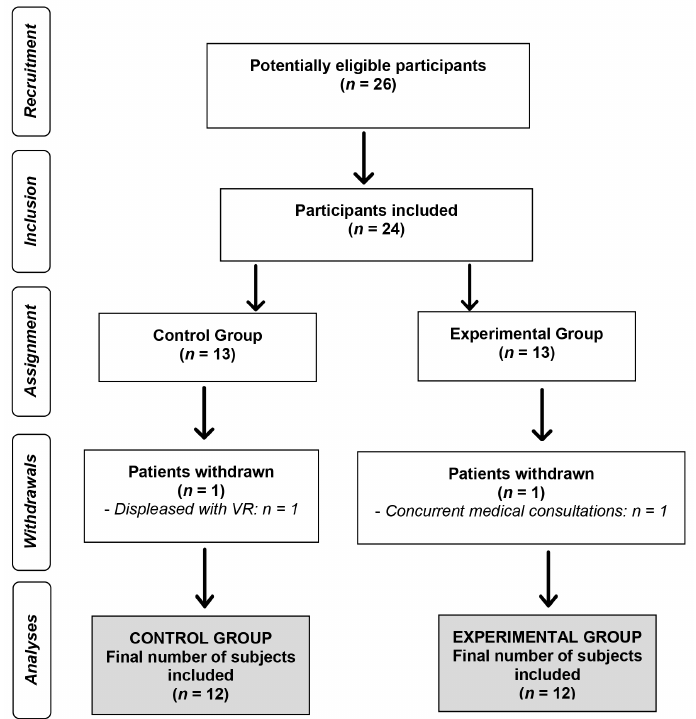
Figure 1. Flowchart of the study.